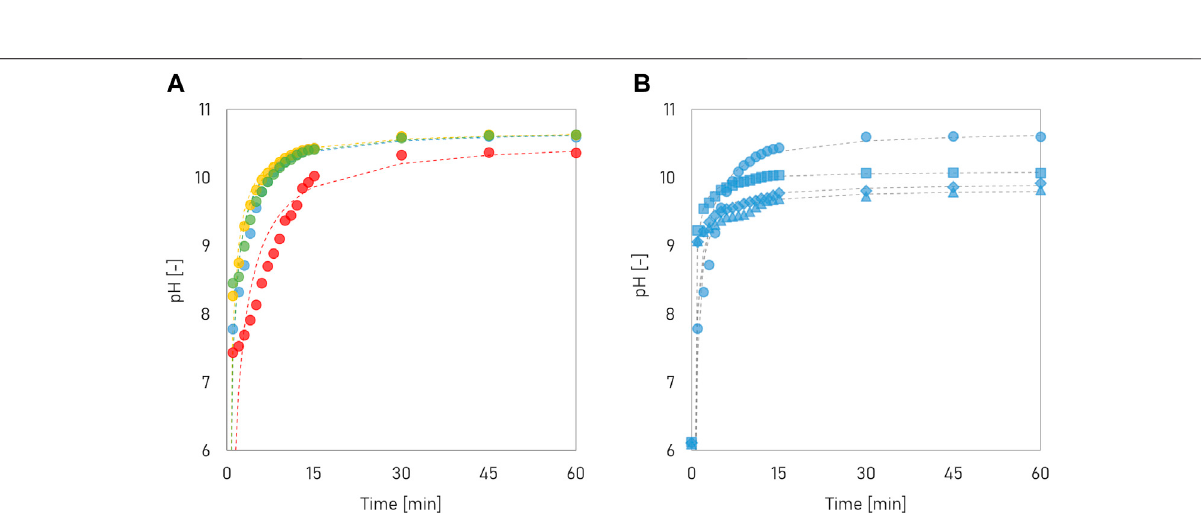
Frontiers in Environmental Science |